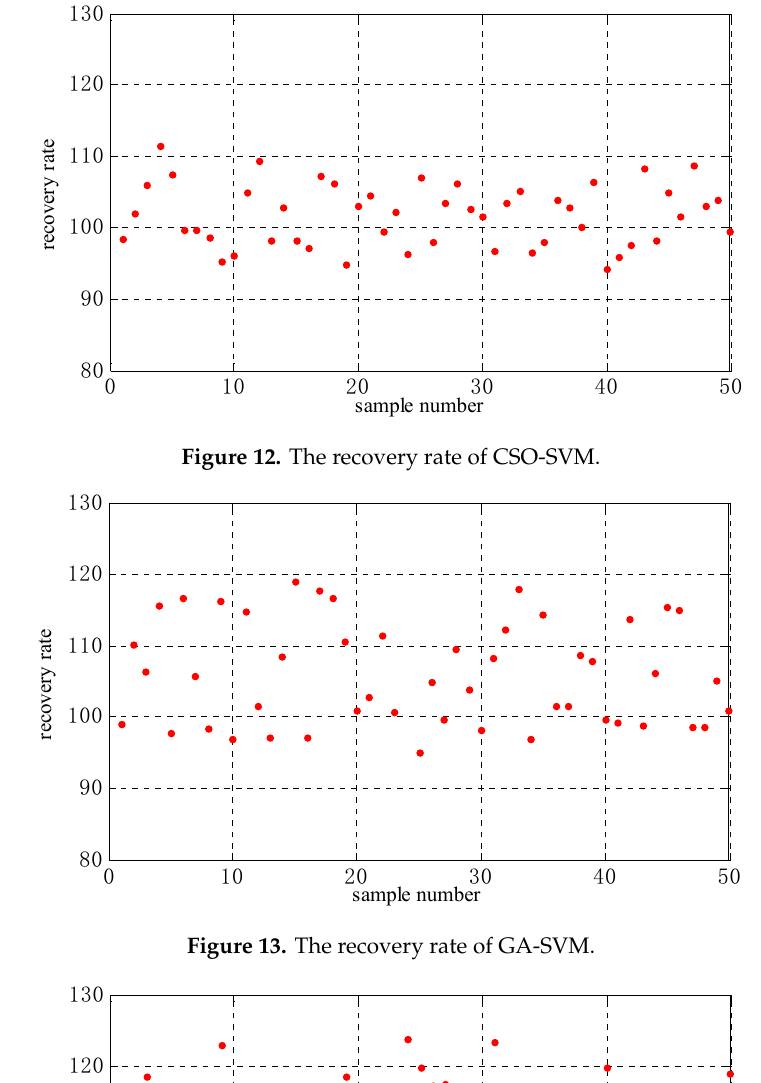
Figure 11. The recovery rate of ICSO-SVM.